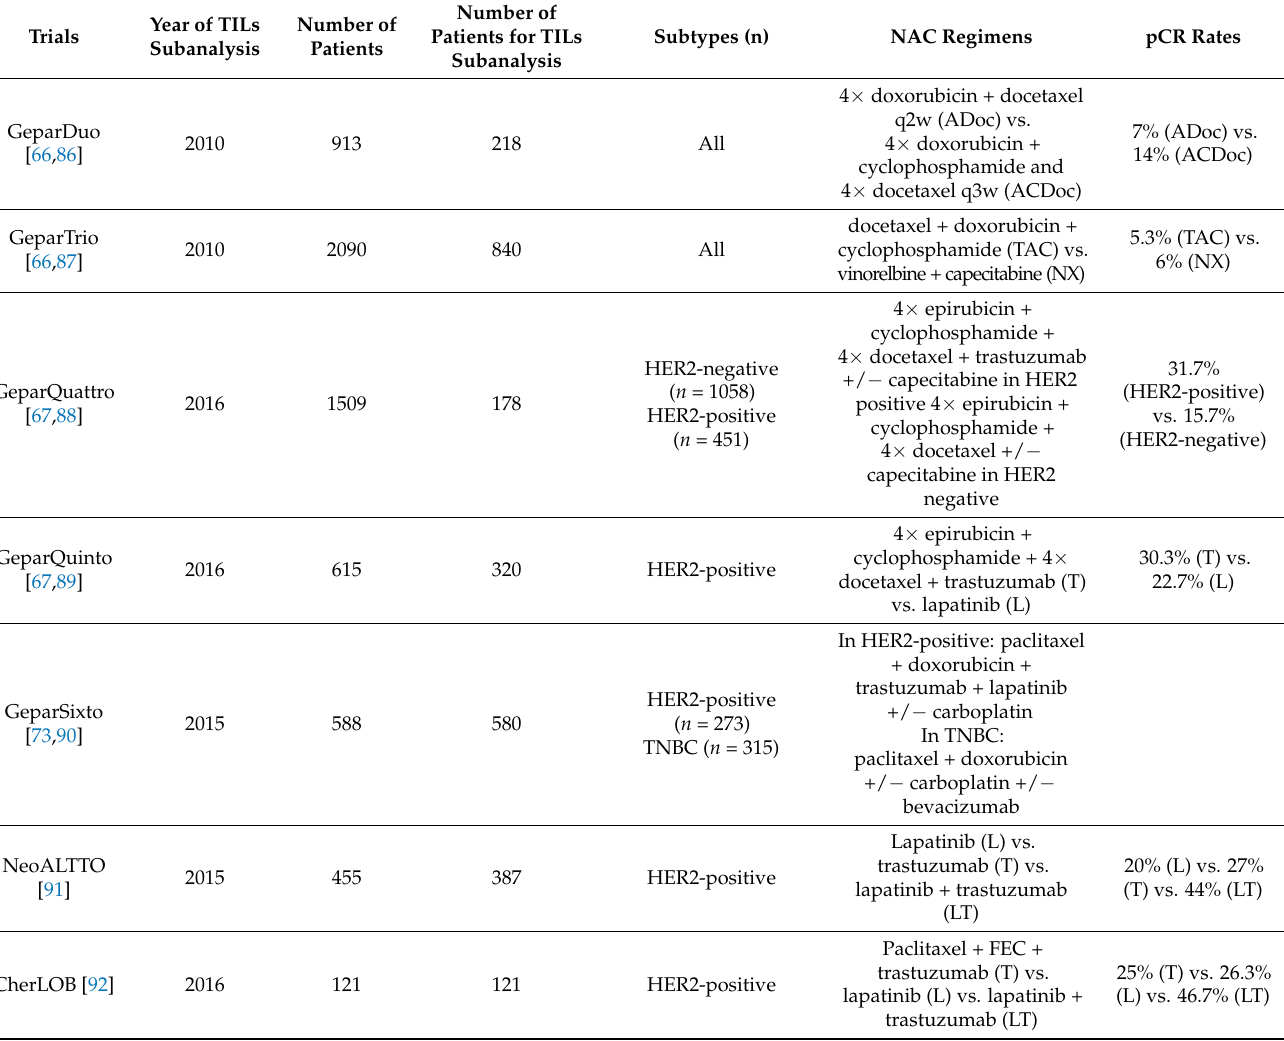
Table 2. Secondary analysis studies evaluating TILs as predictive biomarkers in the neoadjuvant